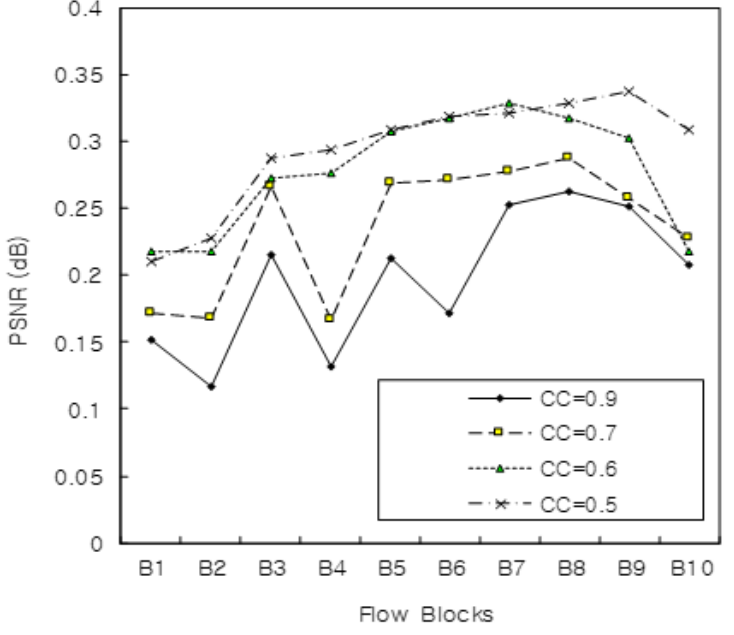
Figure 6. PSNR with flow blocks.